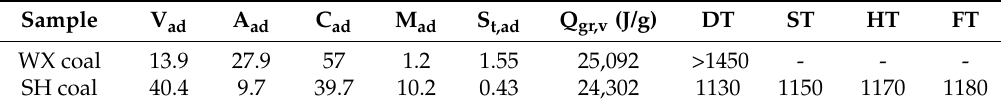
Table 1. Proximate analyses (%) and ash fusion points ( ˝ C) of the coals (DT, deformation temperature; ST, soft temperature; HT, hemispherical temperature; FT, fluid temperature).